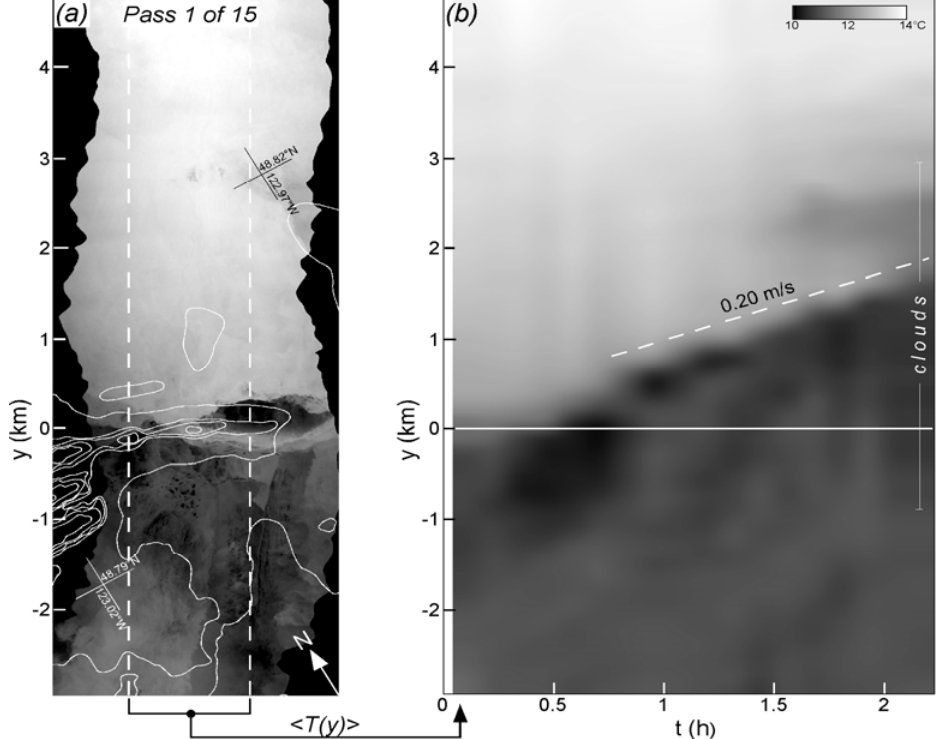
Figure 8. ( a ) Geo-strip from the first pass on 18 May 2009. Across-sill distance (y-axis) is measured relative to the sill crest; ( b ) Evolution of the across-sill temperature profile, <T(y)>, using data from 15 passes. Brackets indicate averaging in the along-sill (x) direction between the dashed lines shown in (a). Time is measured from ebb slack (0208 UTC). Cloud-contaminated data (final pass) are extrapolated values. Sloping dashed line indicates a frontal translation speed of 0.20